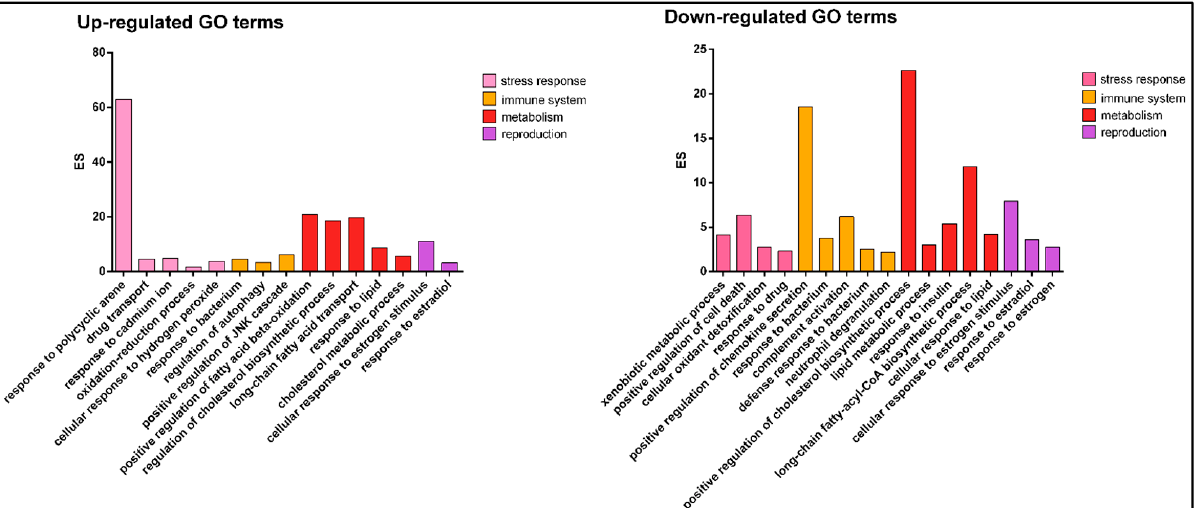
Figure 3. Gene ontology enrichment analysis of differentially expressed genes (DEGs) between liv- ers of immature ( n = 3) and mature ( n = 3) females. y -axis indicates the GO term description; x -axis indicates the gene ratio. The size of the dot is based on gene count, and the color of the dot shows the GO term's enrichment significance ( p -adjust < 0.05).